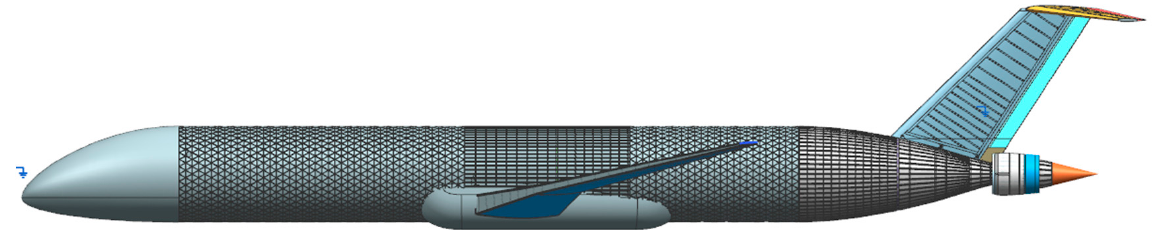
Figure 23. PFC aircraft side view including basic visualization of the main elements of the fuselage structural design concept.